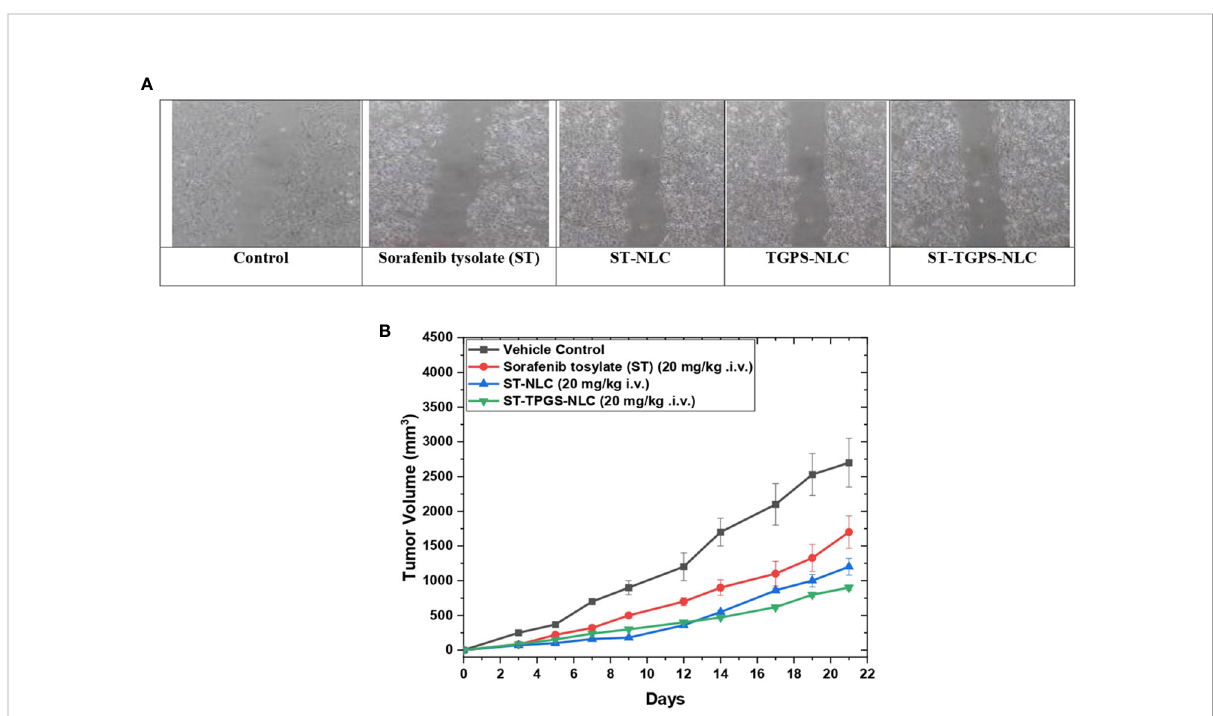
FIGURE 10 Sorafenib tysolate NPs inhibits cell migration. Effect of Sorafenib tysolate(ST), ST-NLC, TGPS-NLC and ST-TGPS-NLC combinations on cell migration in SW46 PTEN Cell lines (A) . Cells were treated for 48h and scratch images were captured at 0, and 24h and analyzed as described in materials and methods. The percent cell migration was expressed as mean ± SD (n=3). where P < 0.05. (B) . Tumor regression study in SW48 Cells PTEN cell lines Xenograft model showing changes in relative tumour volume with time (days) of different groups of SCID (severe combined immunode fi ciency disorder) mice (n=6) treated with Sorafenib tysolate (ST), ST-NLC and TGPS-NLC (ST equivalent concentration 20 mg/kg, i.v.).